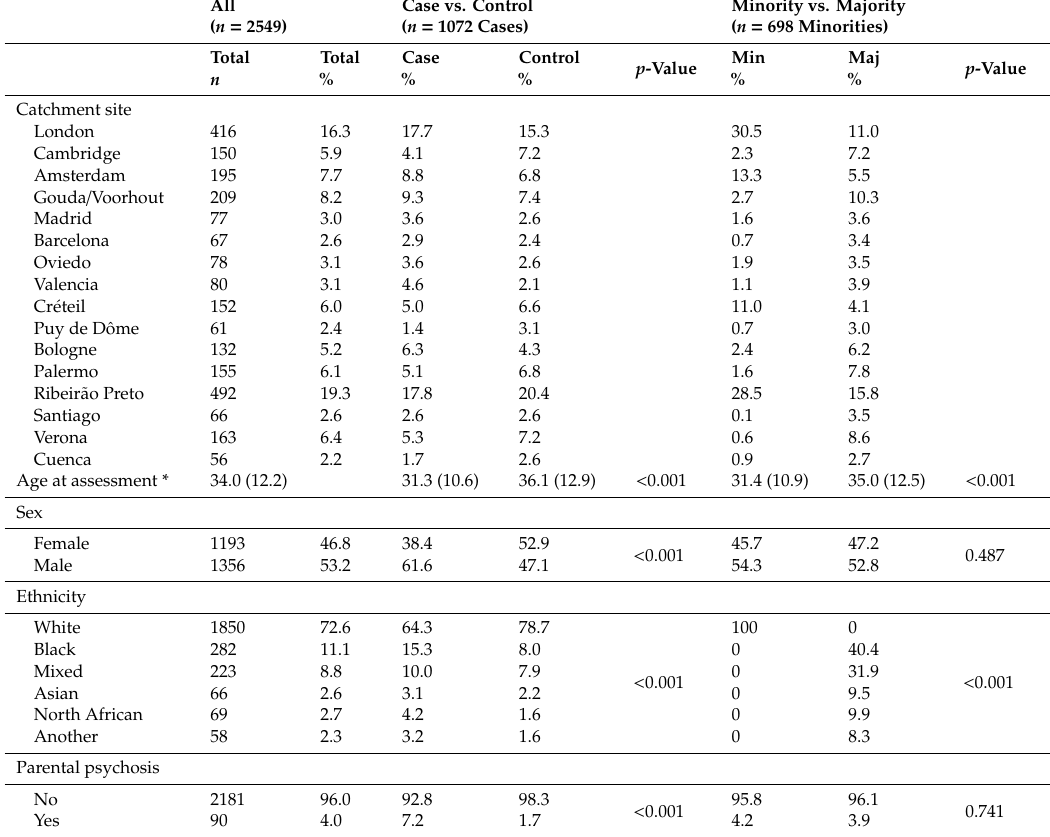
Table 1. Sociodemographic characteristics of the European Network of National Schizophrenia Networks Studying Gene-Environment Interactions (EU-GEI) case-control sample by case status and by ethnic group.